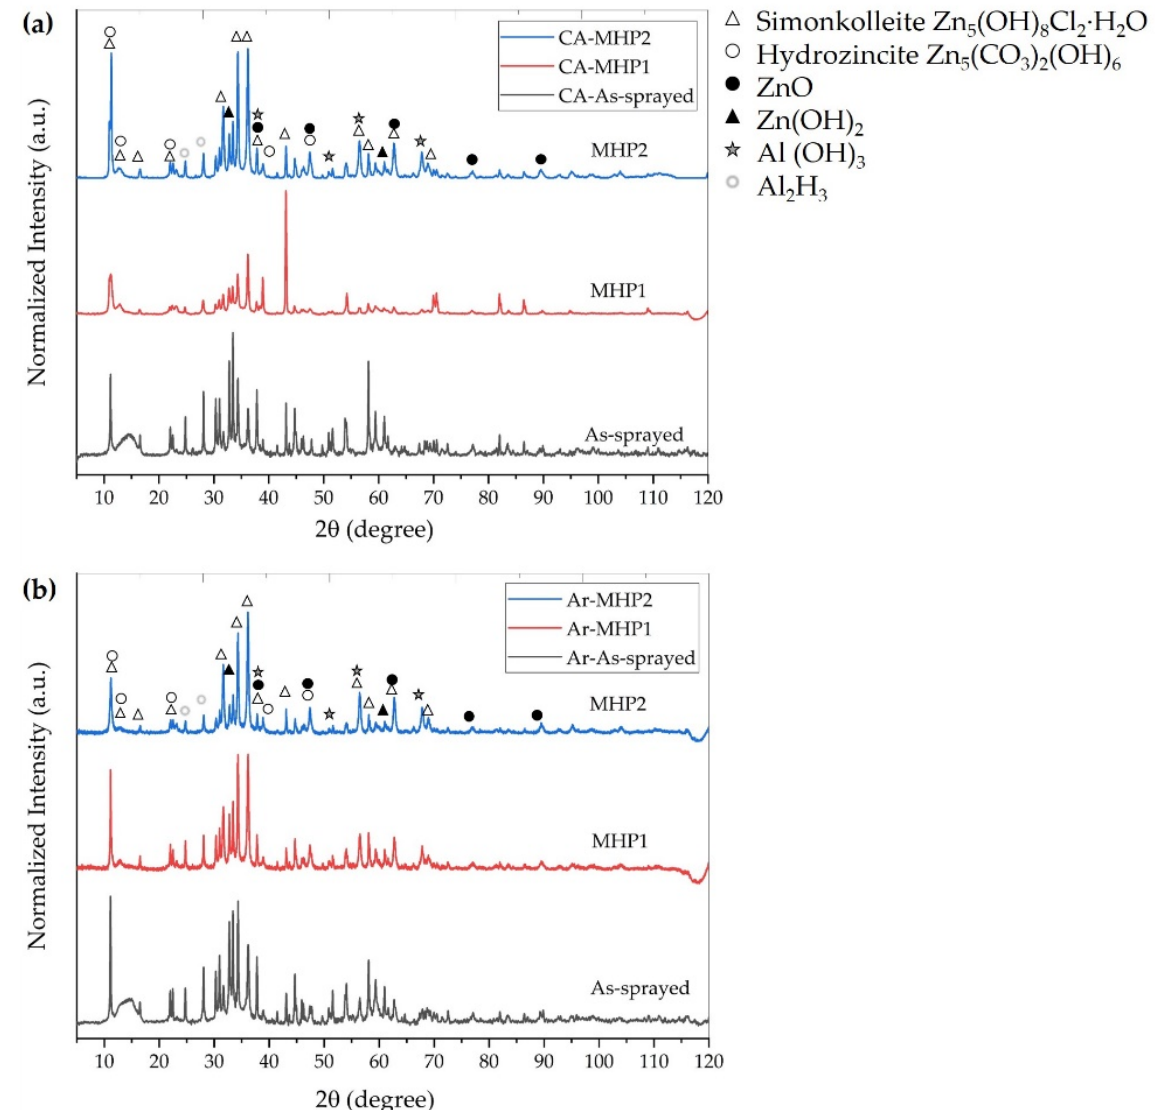
Figure 15. XRD patterns of the Zn–Al diffusion layer corrosion products during salt spray corrosion test after 800 h of ( a ) compressed air sprayed coatings and ( b ) argon sprayed coatings.